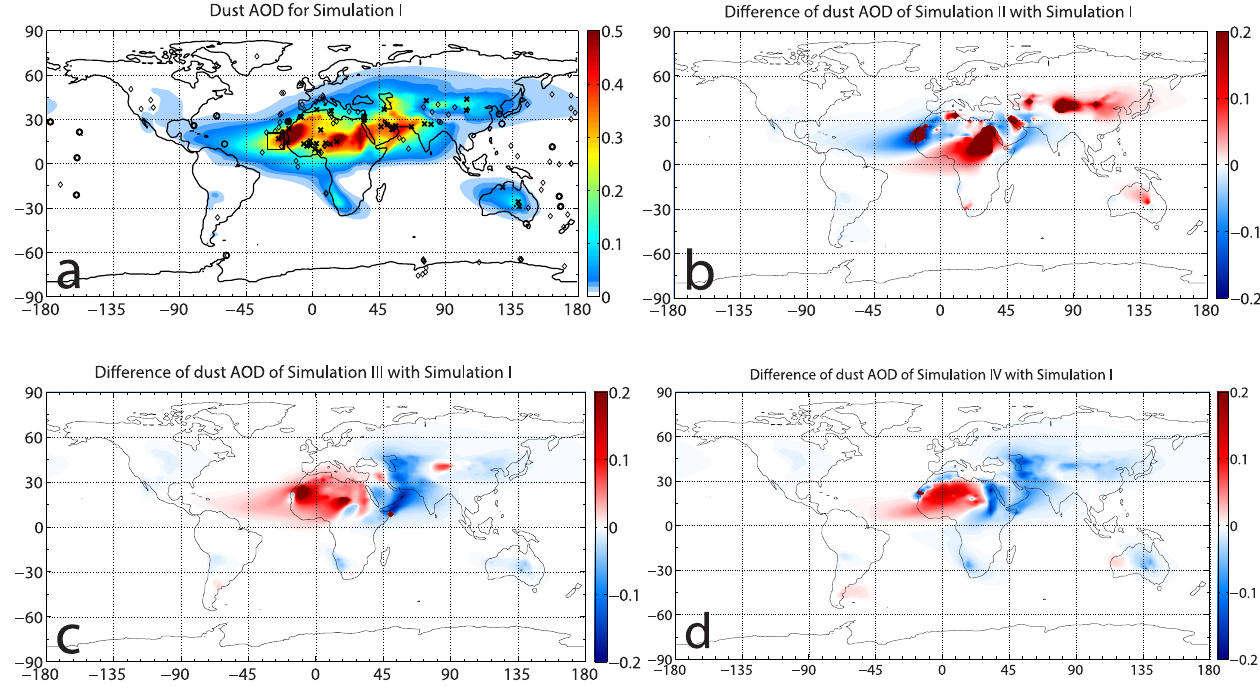
Figure 4. Global maps of (a) the dust AOD of simulation I, and ( b–d ) the difference of dust AOD from simulations II–IV with that of simulation I. Red shading denotes increases in dust AOD relative to the “control” (simulation I). Black symbols in panel (a) are as defined in Fig. 3.